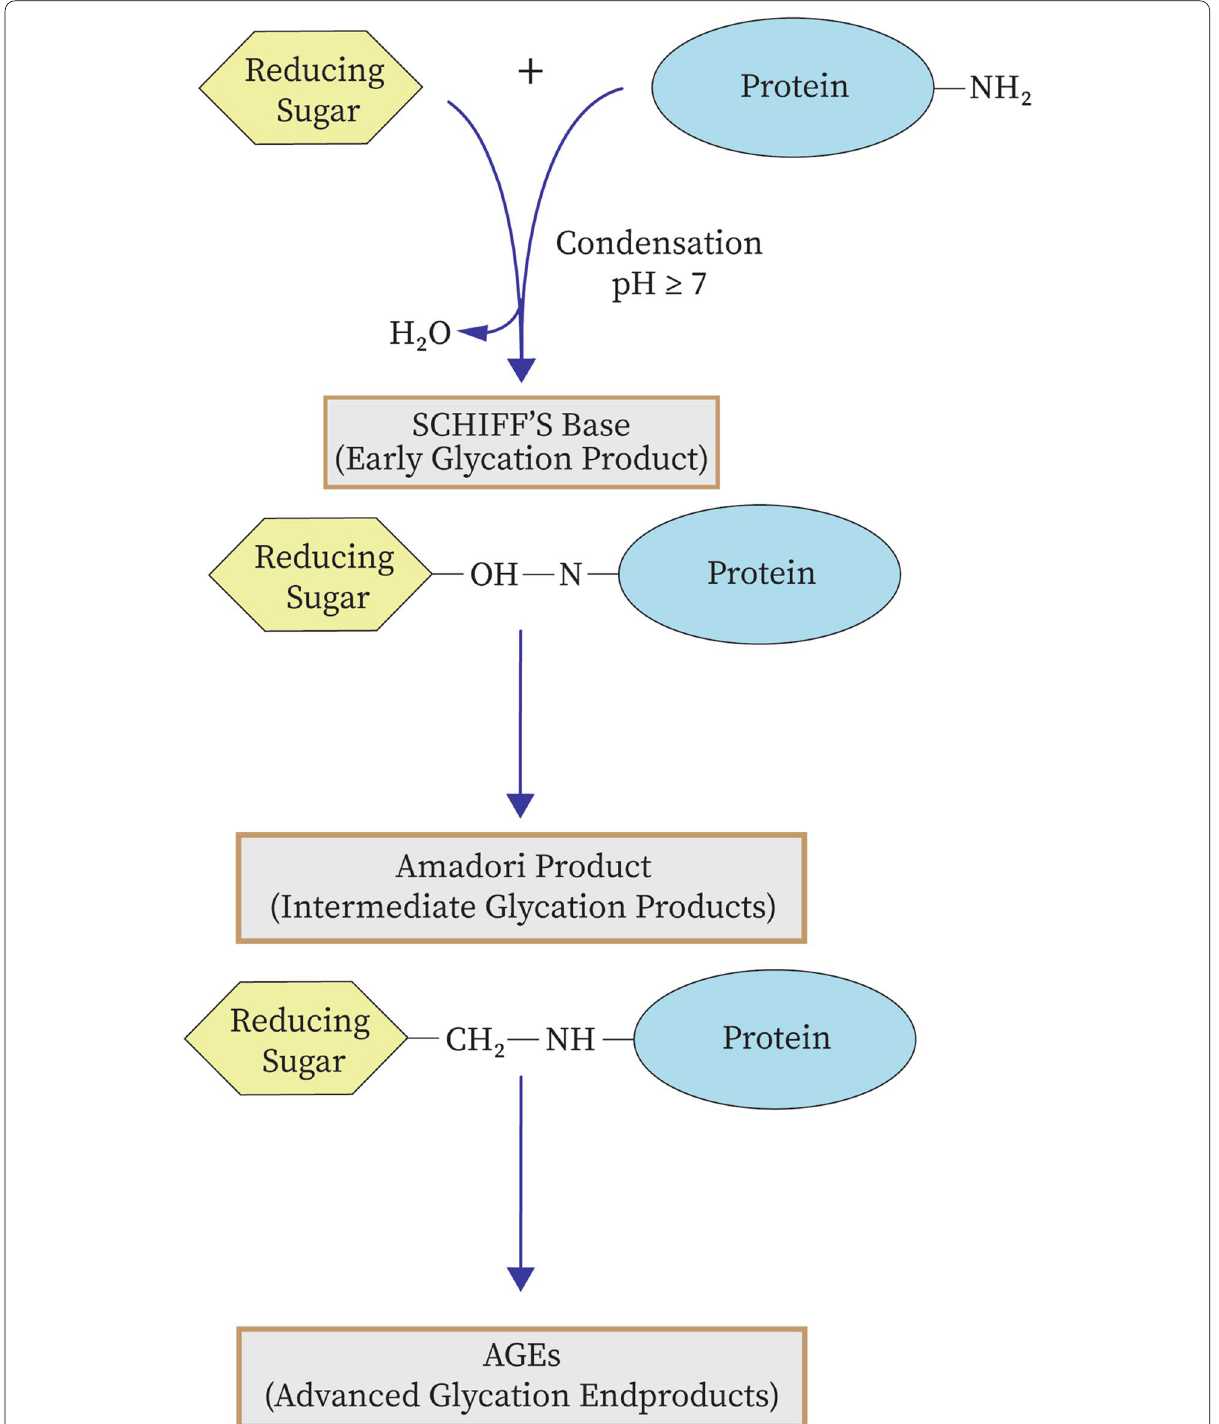
Fig. 2 Maillard reaction for the formation of advanced glycation